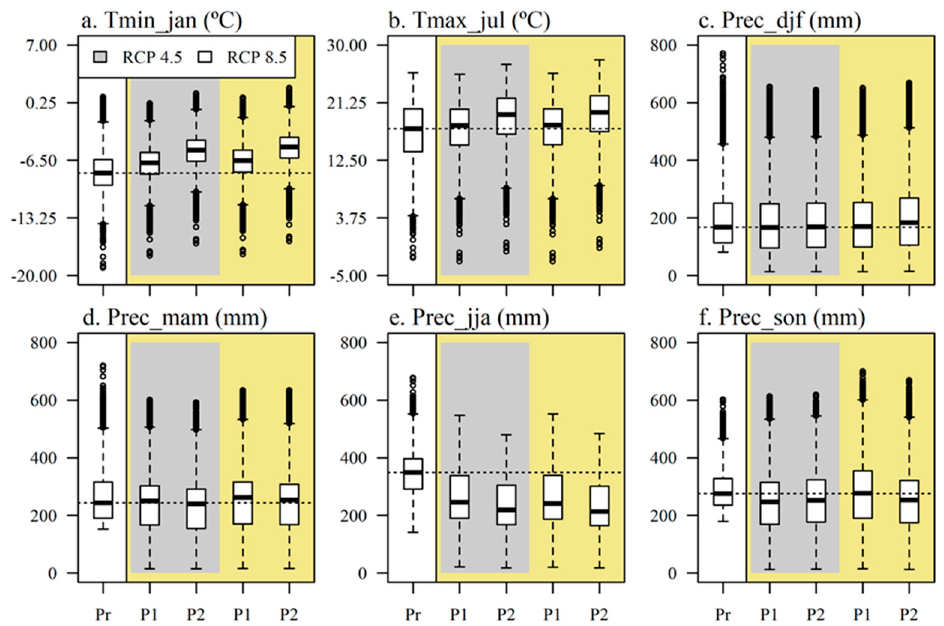
Figure 2. Trends in independent climatic variables (Tmin_jan = Tmin in January ( a ), Tmax_jul = Tmax in July ( b ), and the four seasonal cumulated precipitations, namely Prec_djf ( c ), Prec_mam ( d ), Prec_jja ( e ), Prec_son ( f )) calculated over multiple years using the modelling ensemble (EN), for two climate scenarios (RCP 4.5 and 8.5) and time-slices (P1 = 2011–2040 and P2 = 2041–2070, respectively) compared to the present (PR = 1970–2000). Black lines show the median while the dotted line represents the median of the present along the scenarios. Boxes delimit the 25th and 75th percentiles. Whiskers are 10th and 90th percentiles.